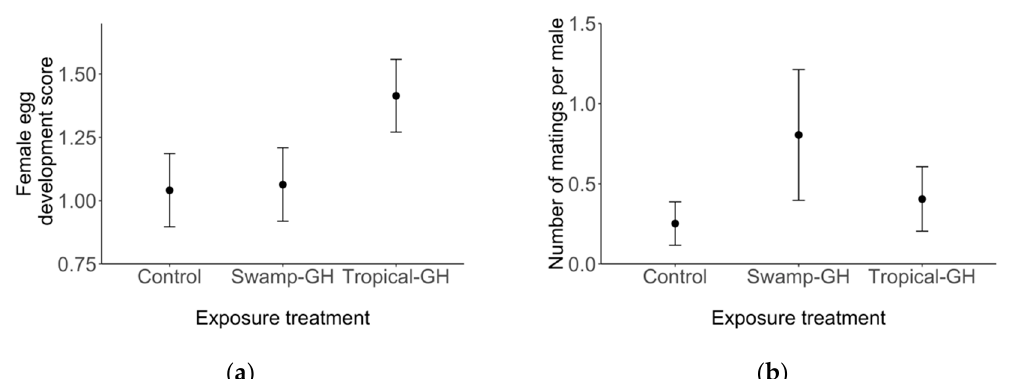
Figure 4. Reproductive traits of wild-caught monarch females and males in relation to milkweed exposure treatments. Points represent the predicted results of the linear mixed model. ( a ) Wild female migrants showed higher egg development scores following exposure to greenhouse-grown tropical milkweed (Tropical-GH), compared to native swamp milkweed (Swamp-GH), or to control treatments. ( b ) Males in the native swamp milkweed treatment (Swamp-GH) had higher numbers of matings than males in other treatments. Error bars represent ± SE. Full model outputs are reported in Tables S6 and S9.